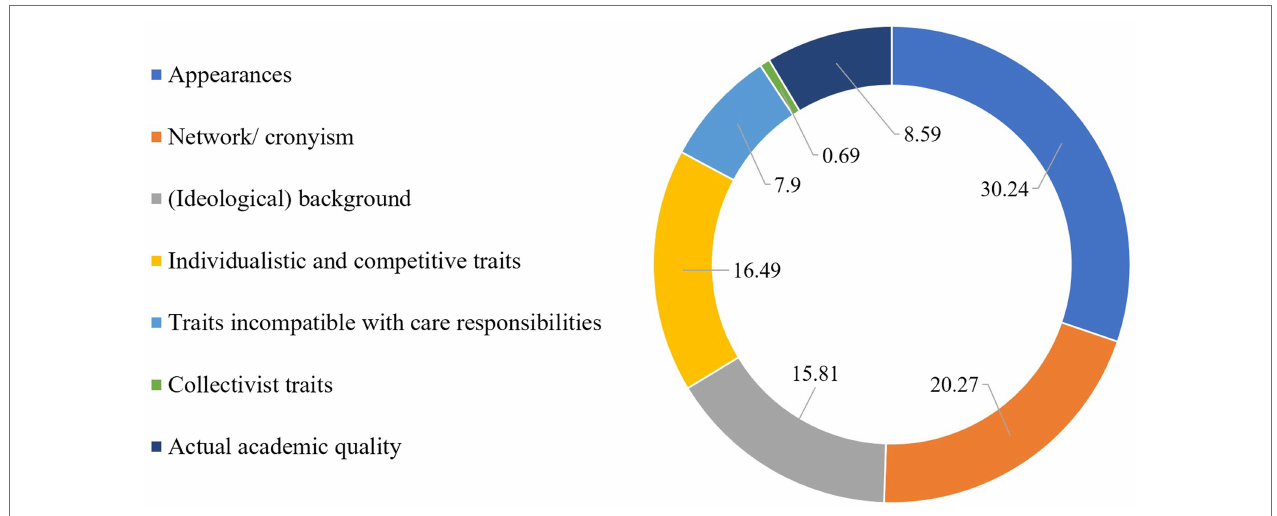
FIGURE 4 | Attributes affording privilege in